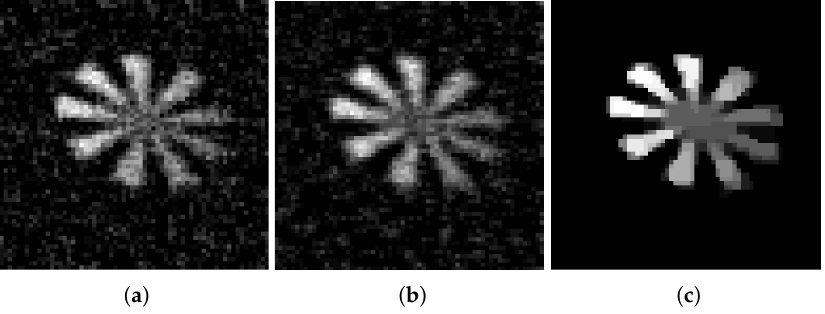
Figure 8. In the case of the sampling rate is 0.4, the image measured by adaptive measurement matrix reconstructed by OMP ( a ), IHT ( b ), and TVAL3 ( c ) algorithms. The resolution of the image is all 64 ×